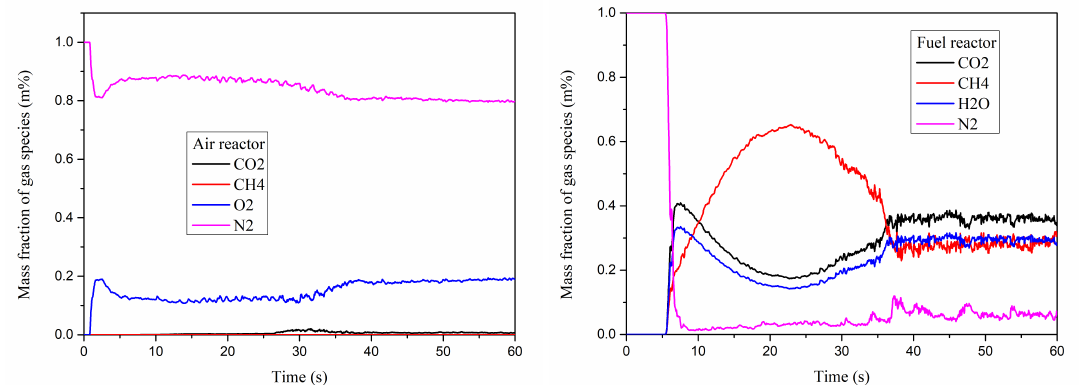
Figure 5. Time-evolution of mass fraction of gas species. The inlet rate of methane is 0.5